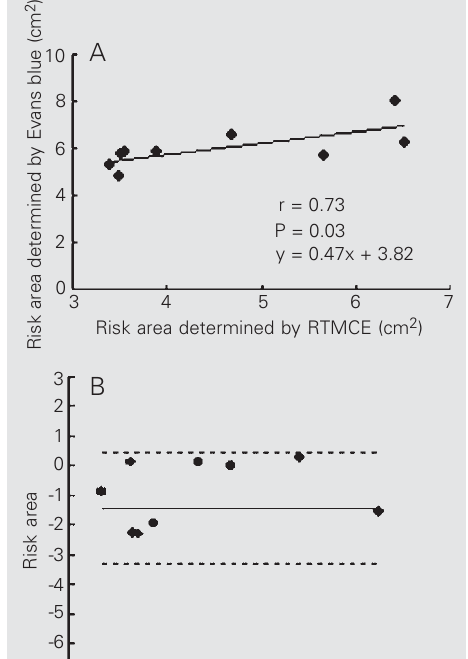
Figure 4. Correlation between infarct size determined by real time myocardial contrast echo- cardiography (RTMCE) and ne- crotic area determined by 2,3,5- triphenyl tetrazolium chloride (TTC) staining (A) and a Bland- Altman plot showing the mean difference (solid line) and limits r = 0.71 of agreement (dashed lines) be- P = 0.002 tween infarct sizes determined y = 0.83x + by the two methods (B).